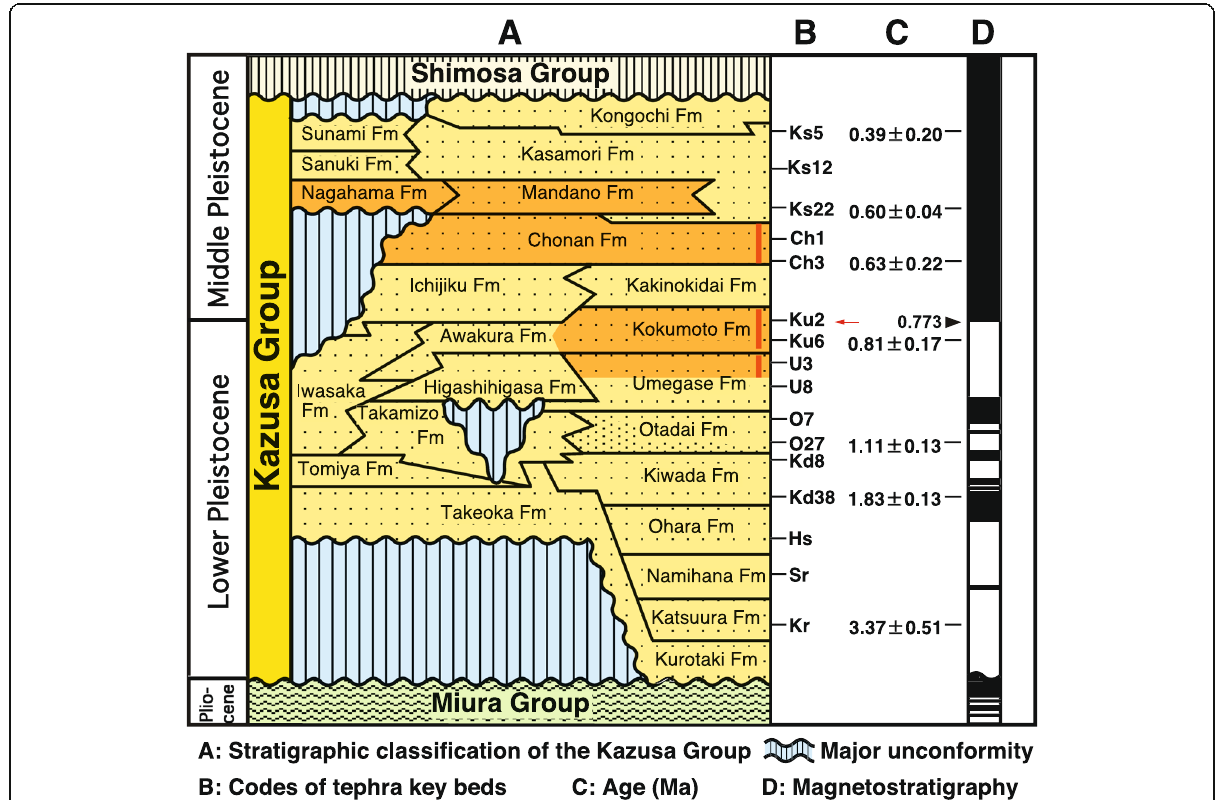
Fig. 2 Stratigraphy of the Kazusa Group on the Boso Peninsula. Modified from Ito (1992). Solid orange lines indicate stratigraphic horizons that are characterized by the development of deep-water massive sandstones. Brown color indicates the stratigraphic units for which descriptions and interpretations of lithofacies features are given in the text. The red arrow between B and C indicates the stratigraphic position of the Chiba composite section. Data sources for this figure are given by Ito (1992). The age of the Matuyama – Brunhes paleomagnetic boundary is corrected to 0.773 Ma following the International Chronostratigraphic Chart v. 2020/01 (International Commission on Stratigraphy,